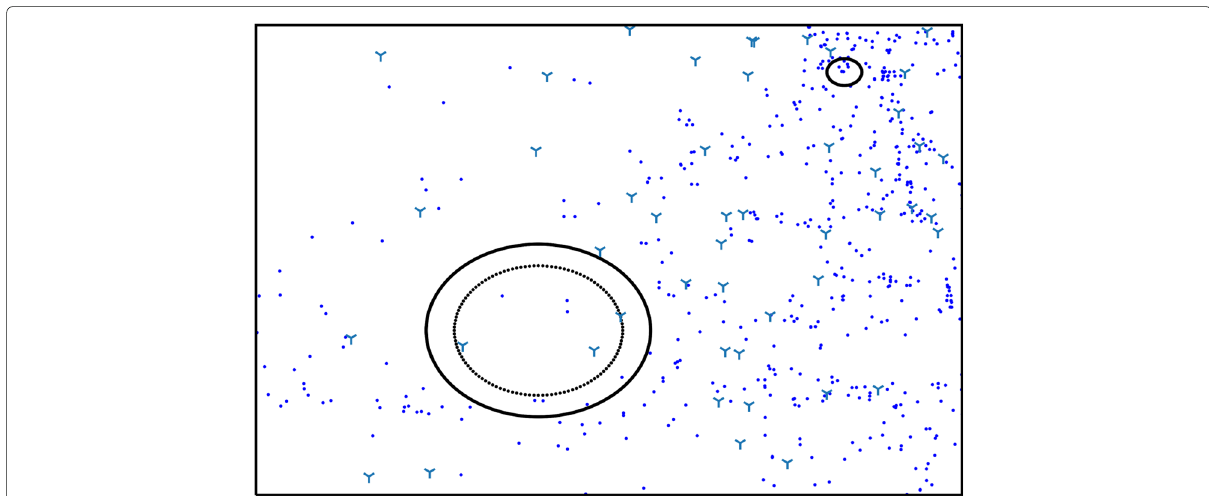
Fig. 9 Landmarks with intermediate routers